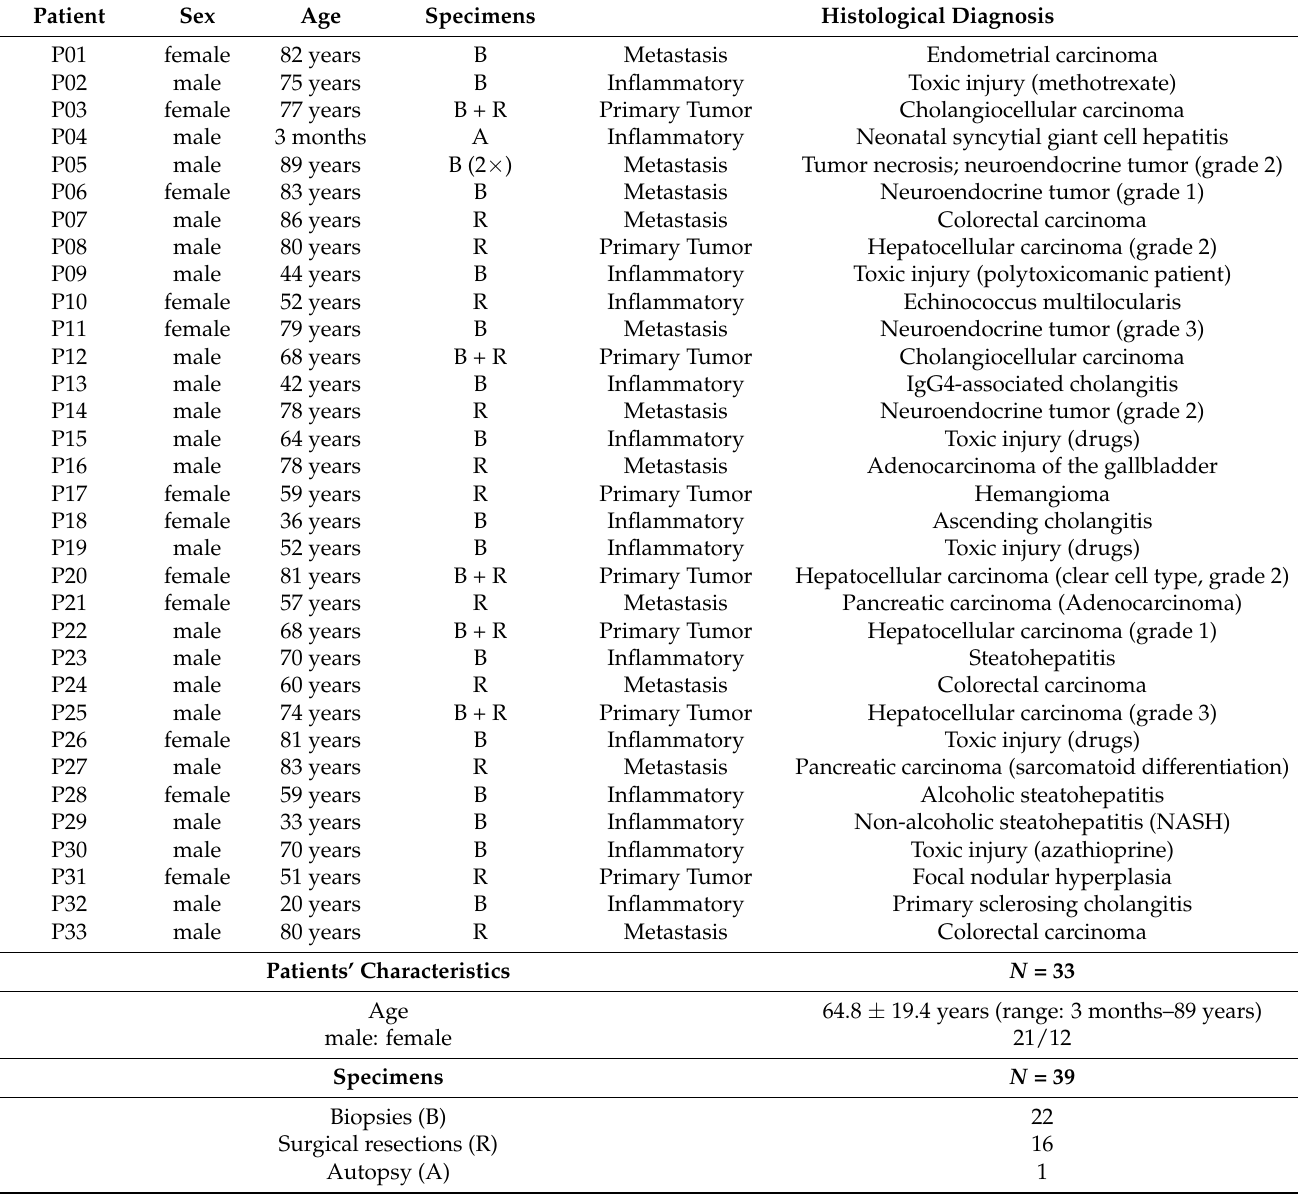
Table 1. Clinical data and diagnoses from histological evaluation of the